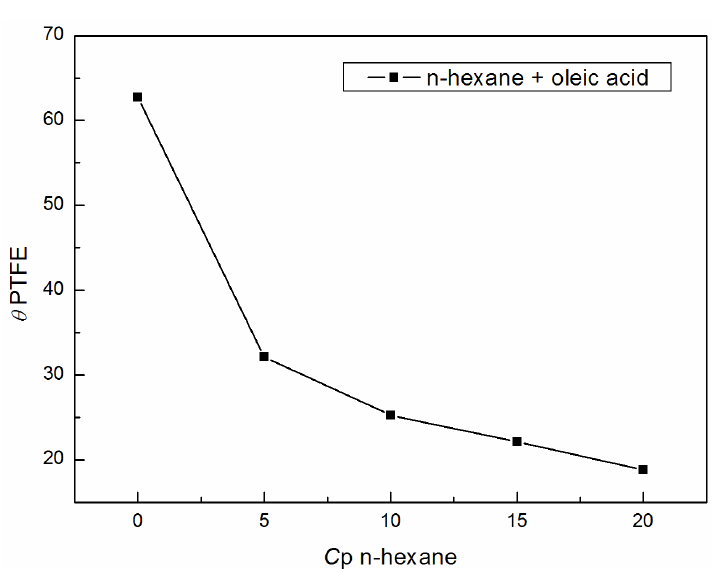
Figure 4. A plot of the contact angle ( θ ) for n-hexane and oleic acid mixtures on the PTFE surface vs. n-hexane percentage concentration ( C p ).